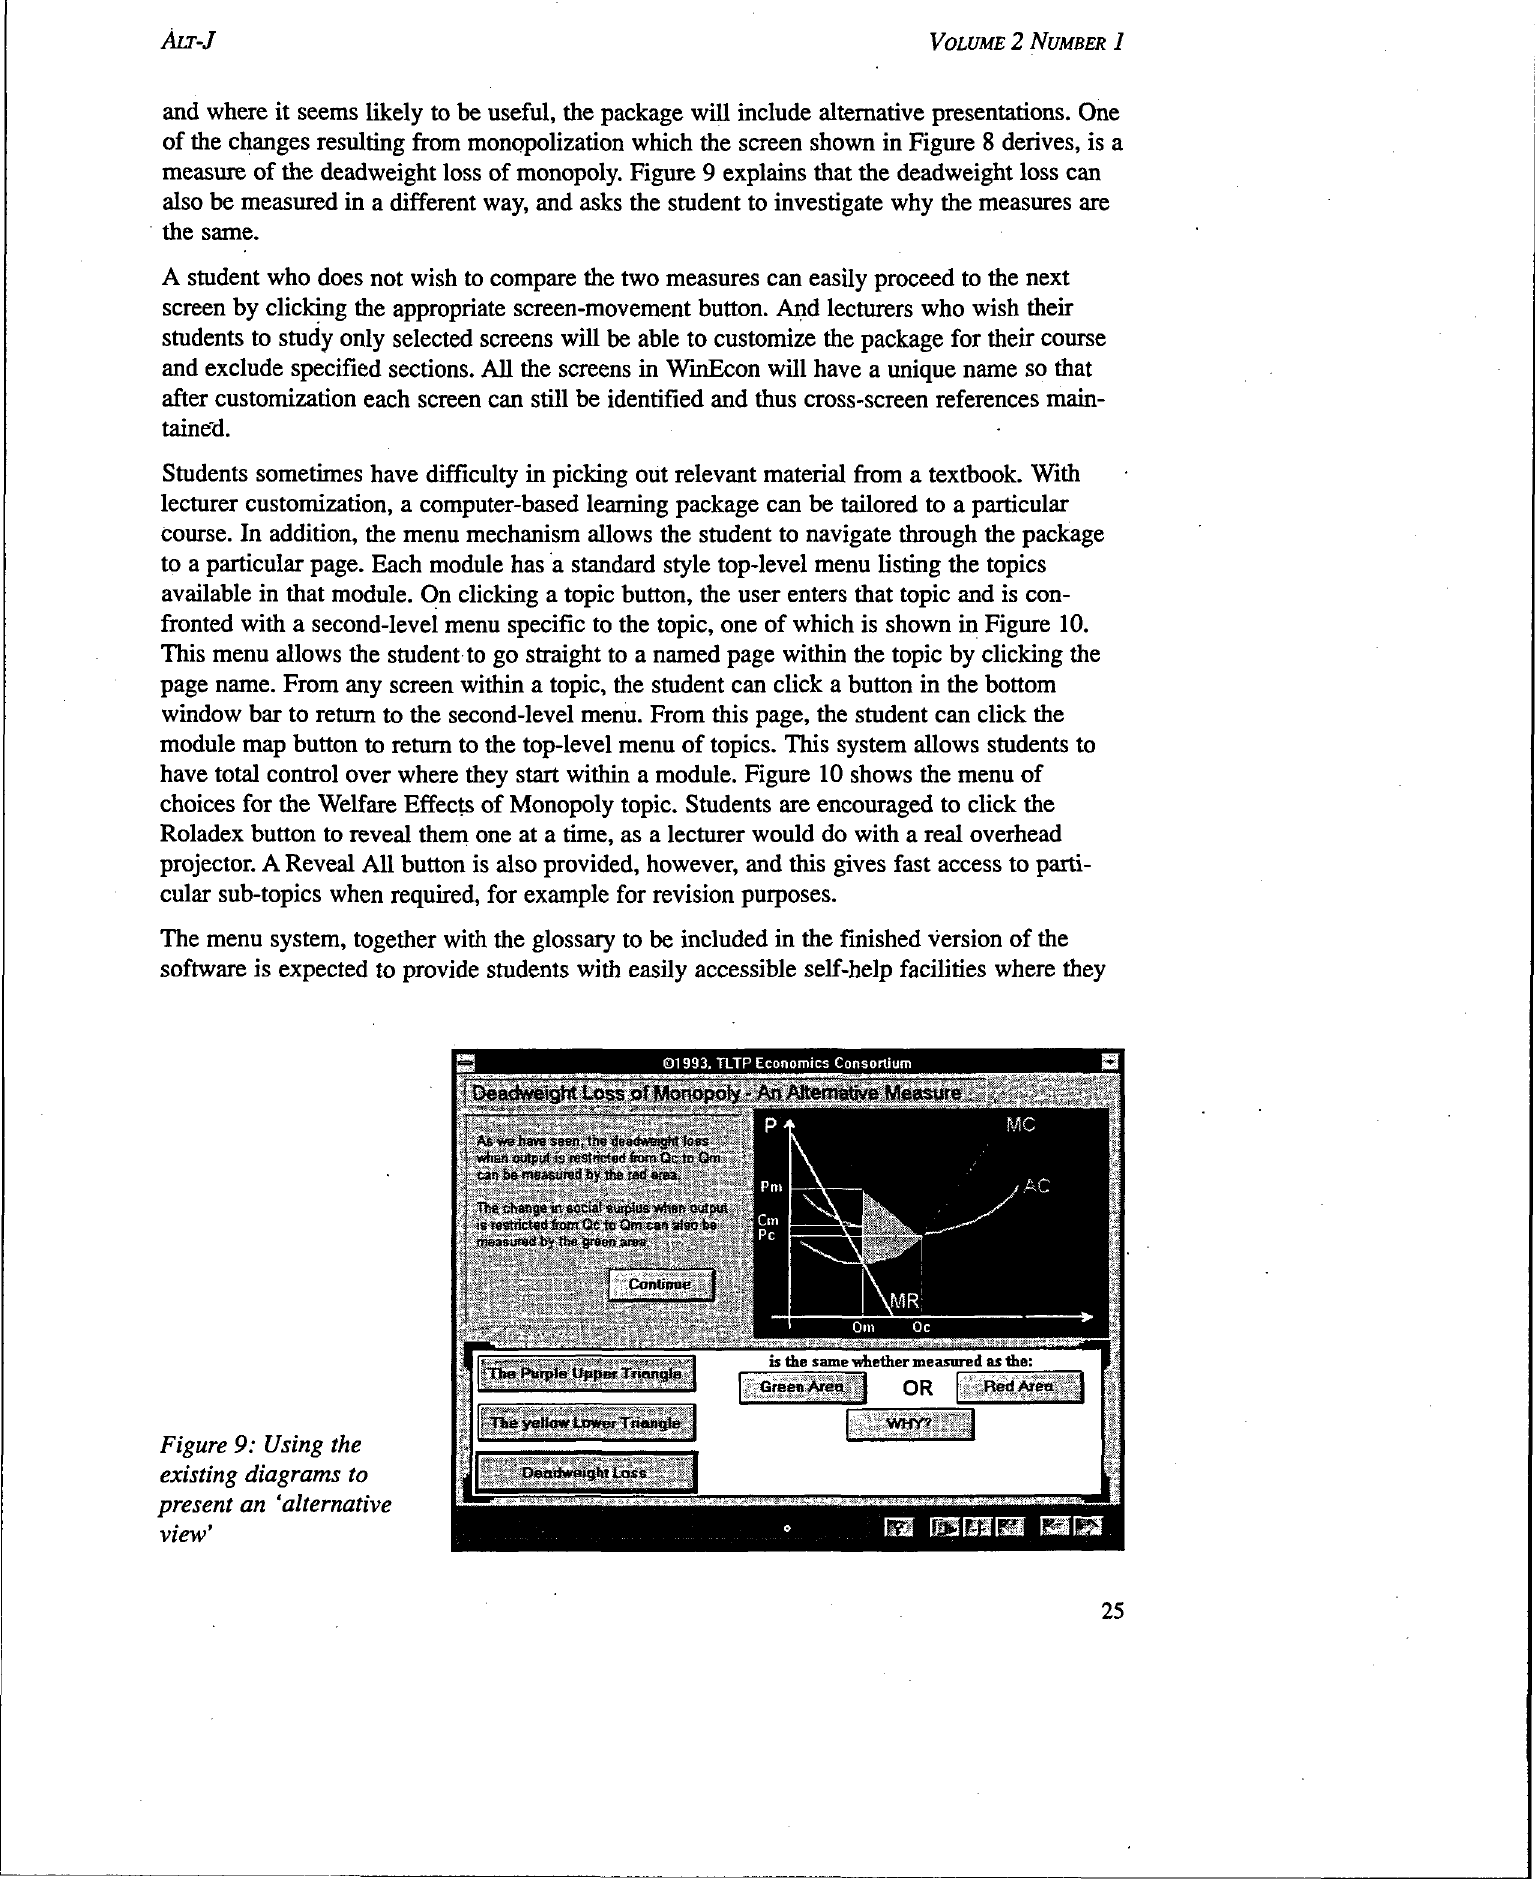
Figure 9: Using the existing diagrams to present an 'alternative view'